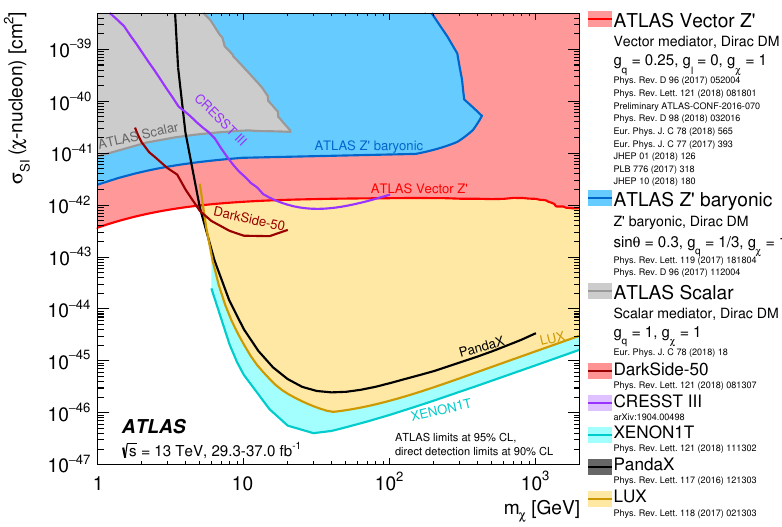
Figure 26. A comparison of the inferred limits with the constraints from direct detection experiments on the spin-independent WIMP-nucleon scattering cross-section. The results from ATLAS analyses, excluding the shaded regions, are compared with limits from direct detection experiments. LHC limits are shown at 95% CL and direct detection limits at 90% CL. The comparison is valid solely in the context of this model, assuming a mediator width (cid:12)xed by the dark matter mass and coupling values g q = 0 : 25, g ‘ = 0 or g q = 0 : 1, g ‘ = 0 : 01 for the neutral-mediator model and coupling g q = 0 : 33 for the baryon-charged mediator. The coupling to the DM particle g (cid:31) , is set to unity in all cases. LHC searches and direct detection experiments exclude the shaded areas. Exclusions of smaller scattering cross-sections do not imply that larger scattering cross-sections are also excluded. The single dijet and E miss + X exclusion region T represents the union of exclusions from all analyses of that